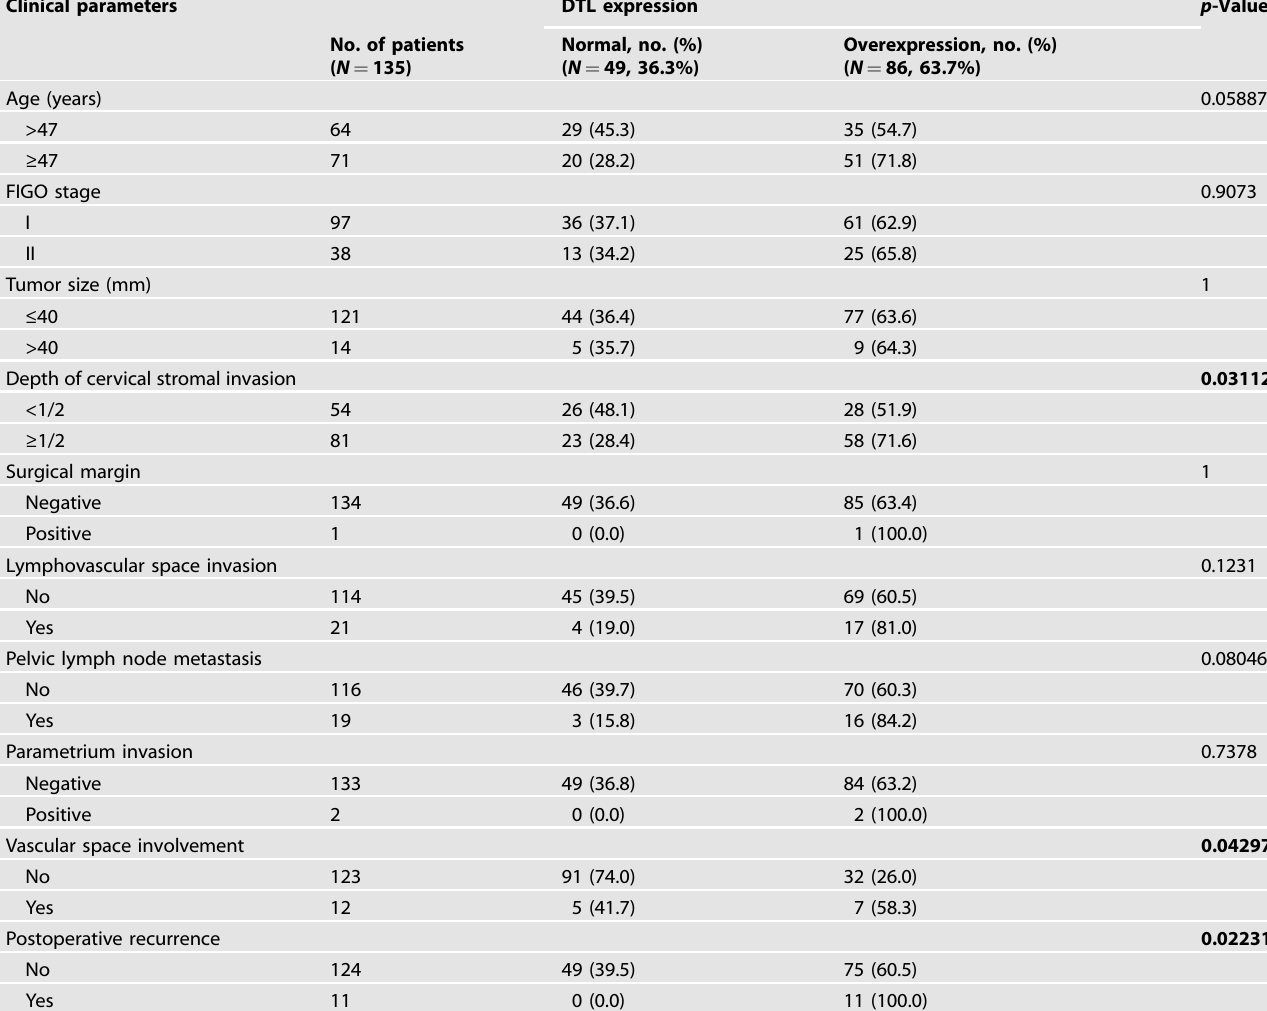
Table 1. Interrelation between DTL expression and clinicopathological features of cervical adenocarcinoma tissues. Clinical